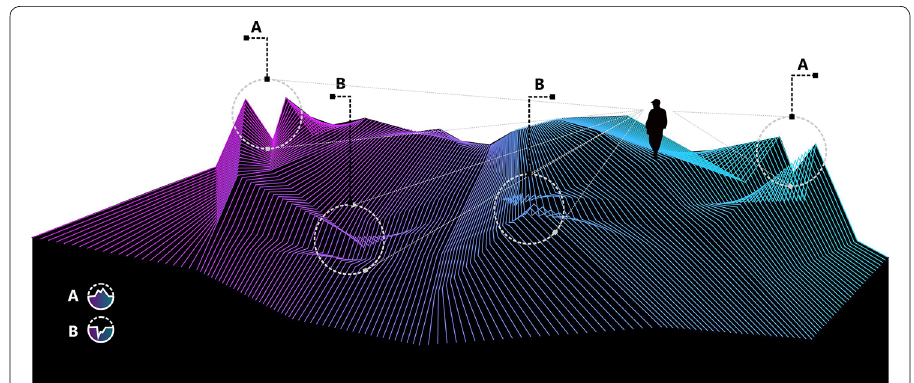
Fig. 8 Immersive Analytics Principle 5: granularity and distribution of data aligned with naturally occurring distribution